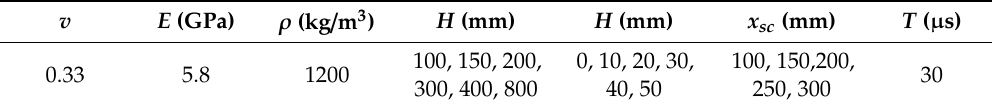
Figure 2. Finite element model of simulating the interaction of surface waves with a surface-breaking crack in a plate. Table 1. Finite element models and parameters.